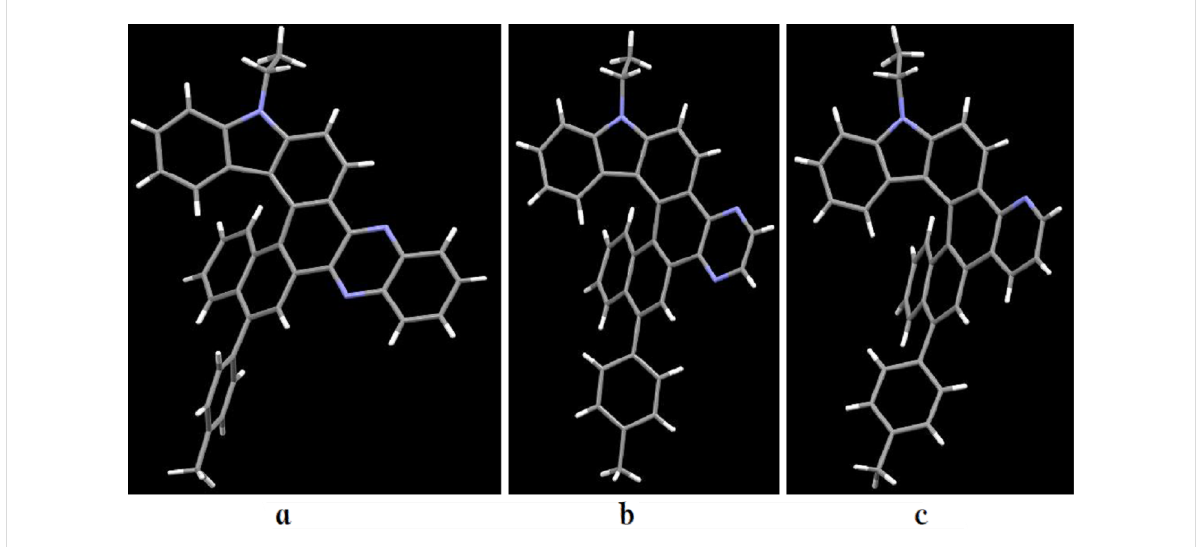
Figure 1: Molecular structure of carbazole-based [6]helicenes 10a (a), 10b (b) and 10c (c) (X-ray data).